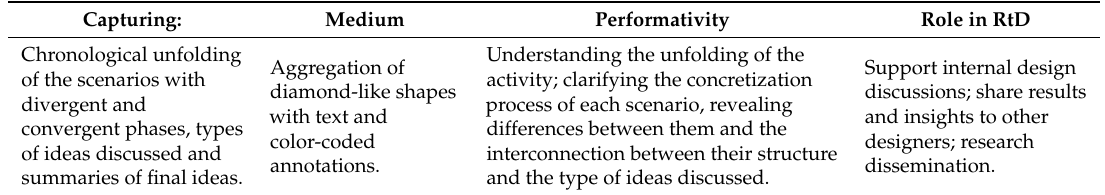
Table 2. Overview of the Double Diamonds’ core qualities and what they